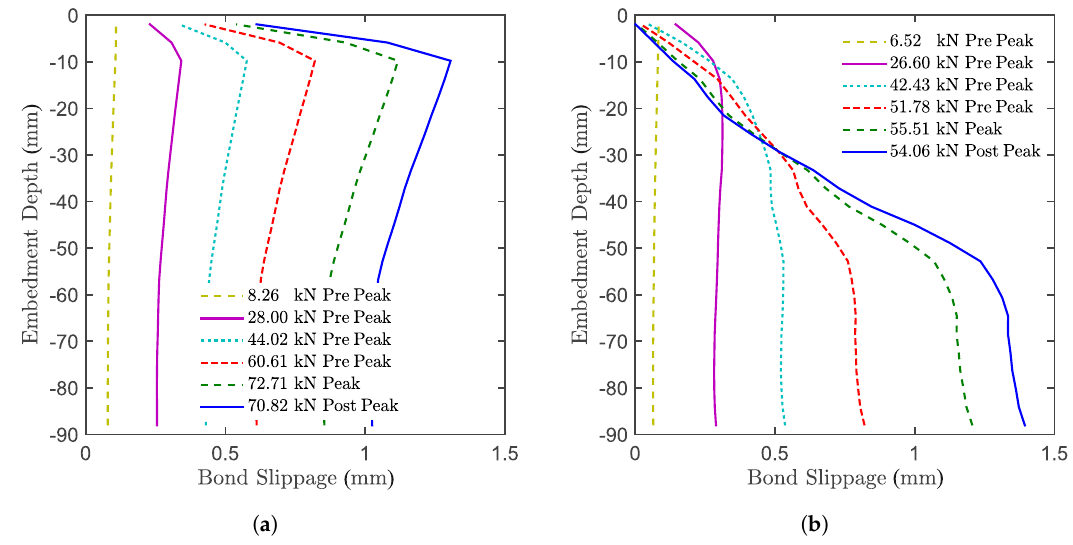
Figure 13. Bond slippage along the anchor in numerical simulations for the ( a ) confined setup and ( b ) unconfined setup.